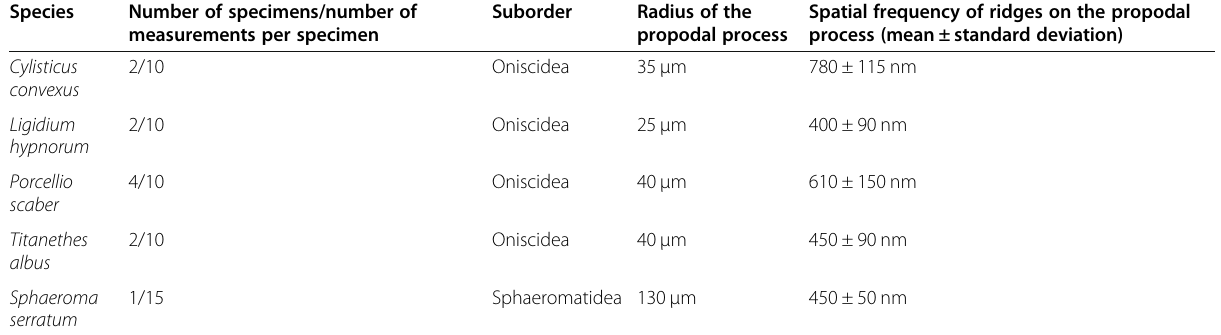
Table 2 Sizes and ridge patterns of propodal processes in different isopod species Species Number of specimens/number of measurements per specimen